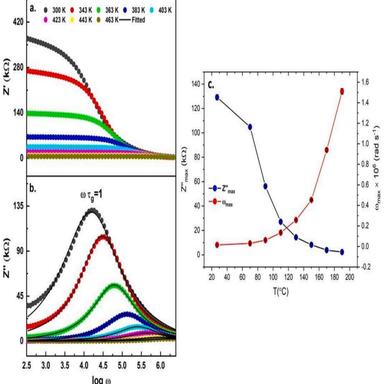
Variation of a) the real part, Z′ and b) the imaginary part, Z'' of impedance with frequency for different temperatures, and c) The fitted Z''max and ωmax from impedance spectra with temperature dependence.